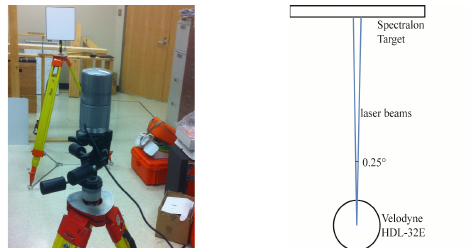
Figure 2. The experimental setup (left) and its diagram on the xy-plane (right) for temporal stability analysis As can be seen from Figures 3 and 4, none of the lasers has stable range measurements over the 9000 s period. Some of them fluctuate by more than 0.05 m, which is at least 3 times greater than the thickness (1.42 cm) of the Spectralon, target assembly. Moreover, an approximate warm-up time of 2000 s was found for most lasers.